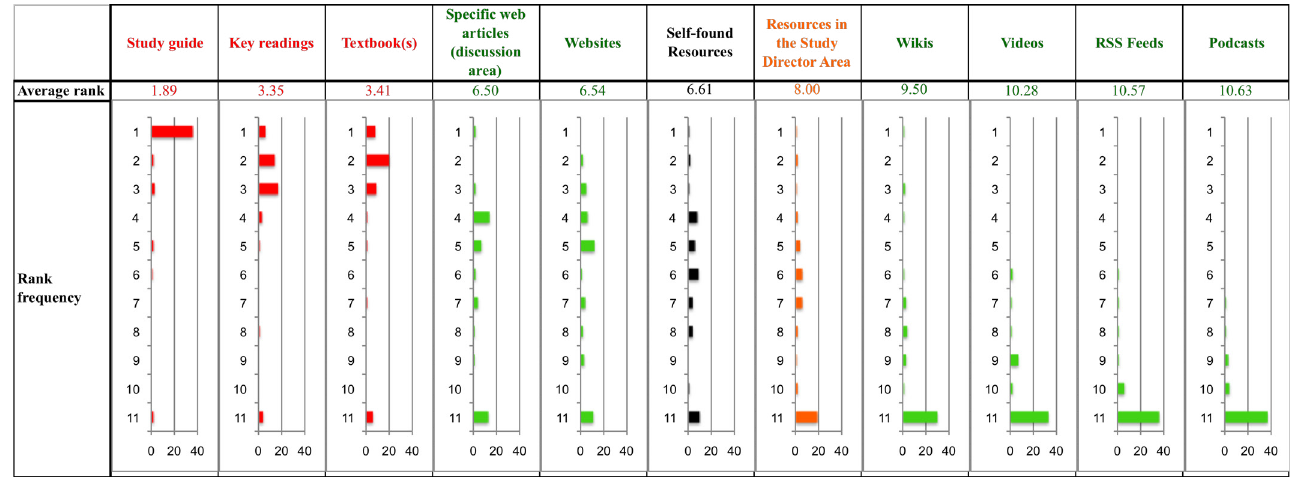
Resource Use, Average Rank, and Rank